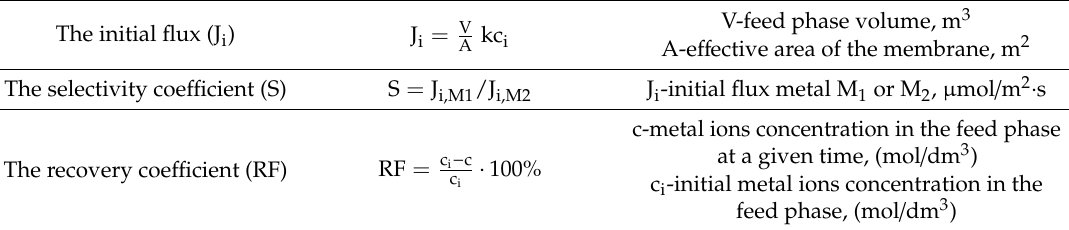
Table 1. The characteristic parameters for the ion transport across